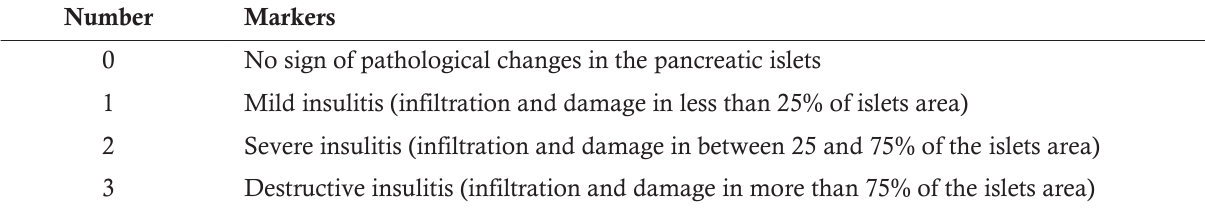
Table 1. Score of pathological changes or injury in the pancreatic islets